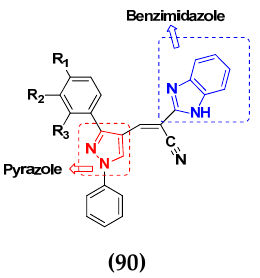
Figure 87. Structure of benzimidazole-pyrazole derivatives ( 90 ). Table 76. In vitro cytotoxic activities of benzimidazole-pyrazole hybrid compounds 90 ( a - b ).